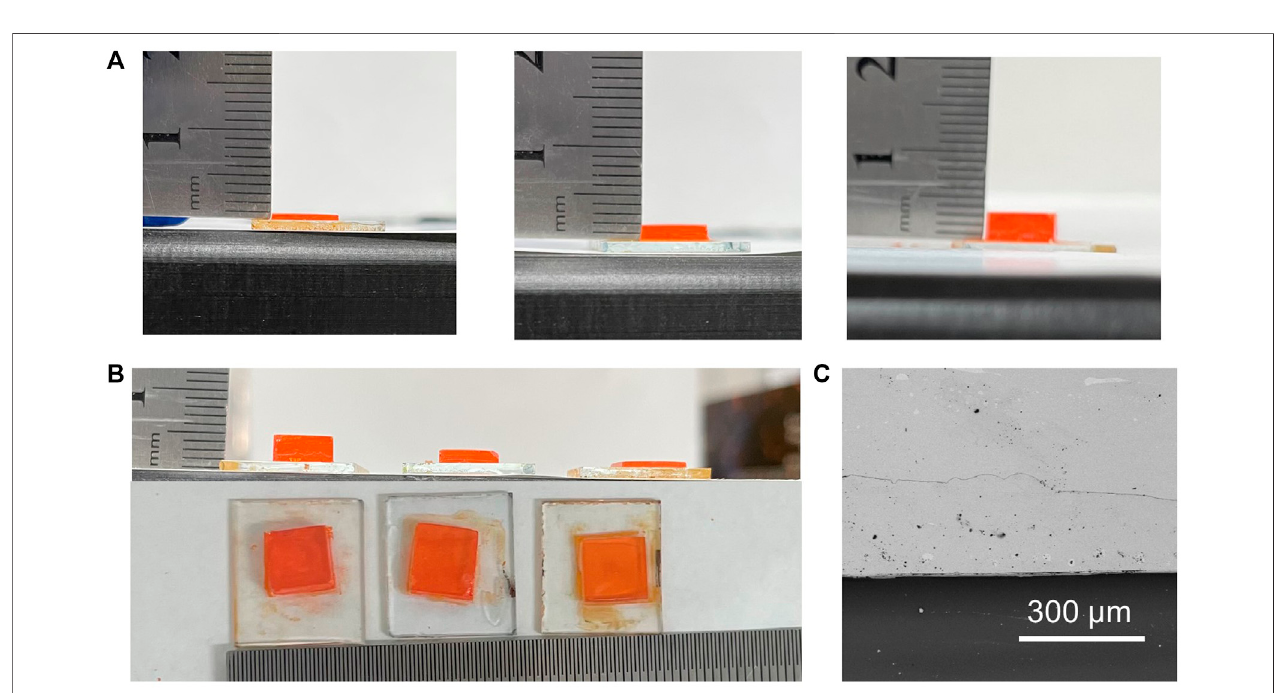
FIGURE 2 | (A) Photographs of the as-grown MAPbBr 3 single crystals with thicknesses differing from 1 to 3.5 mm. (B) Different thicknesses of the single crystal with similar size. (C) Cross-sectional SEM images of the MAPbBr 3 single-crystal wafer.